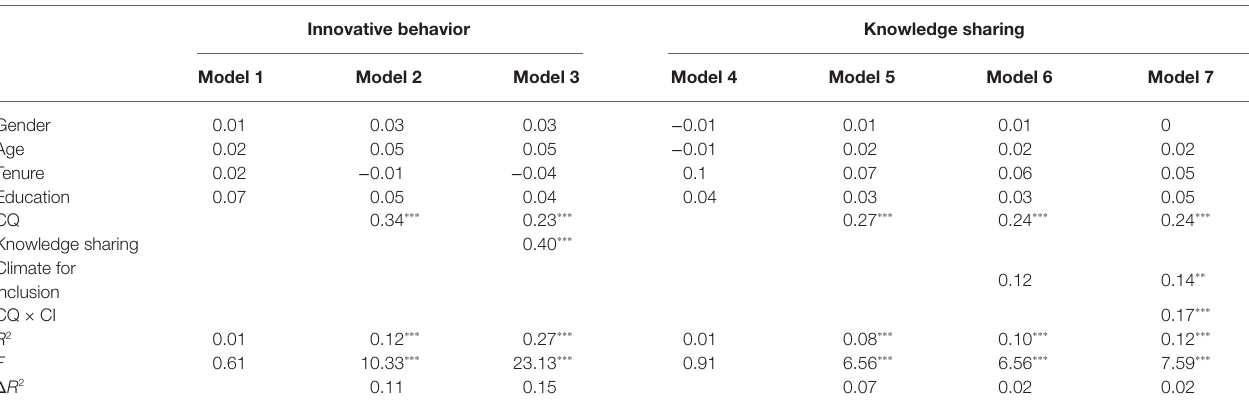
TABLE 3 | Summary of regression